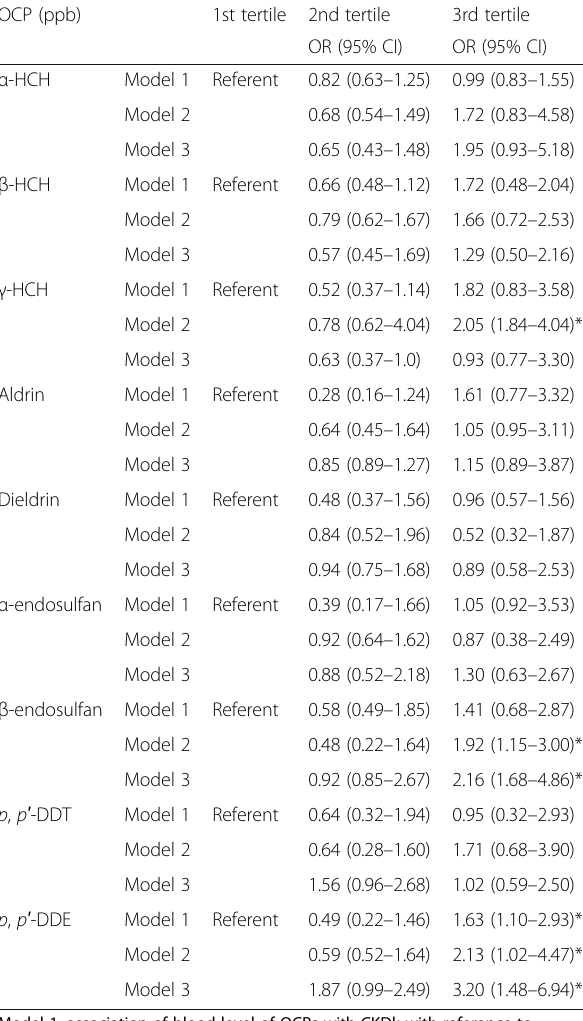
Table 4 Association of organochlorine pesticides with study subjects OCP